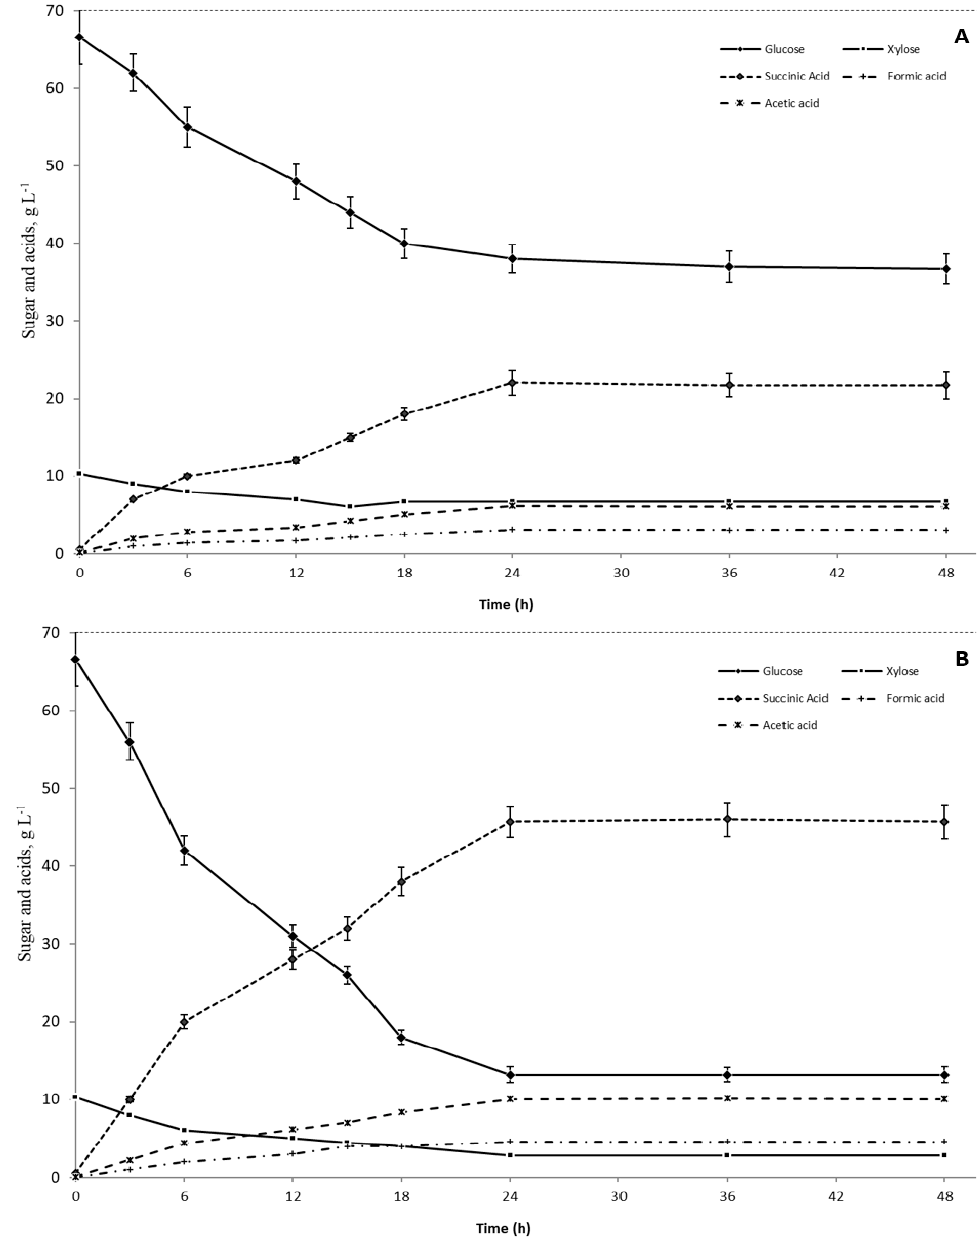
Figure 2. Course of succinic acid fermentation (( A )—process carried out with biogas as CO 2 source, ( B )—process carried out with simultaneous addition of biogas and 20–21 g/dm 3 MgCO 3 /25% of initial dosage; error bars represent standard deviation).